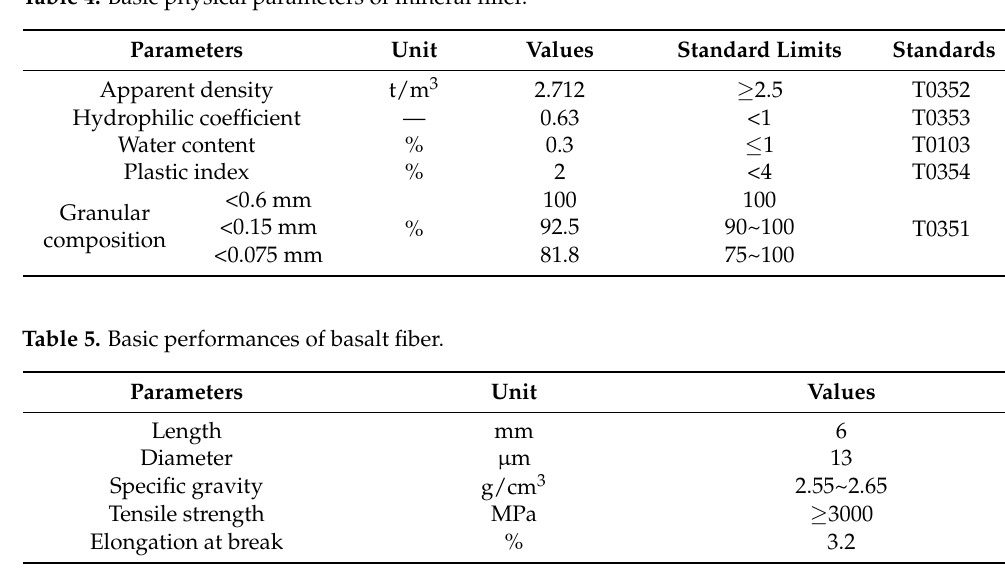
Table 4. Basic physical parameters of mineral filler.